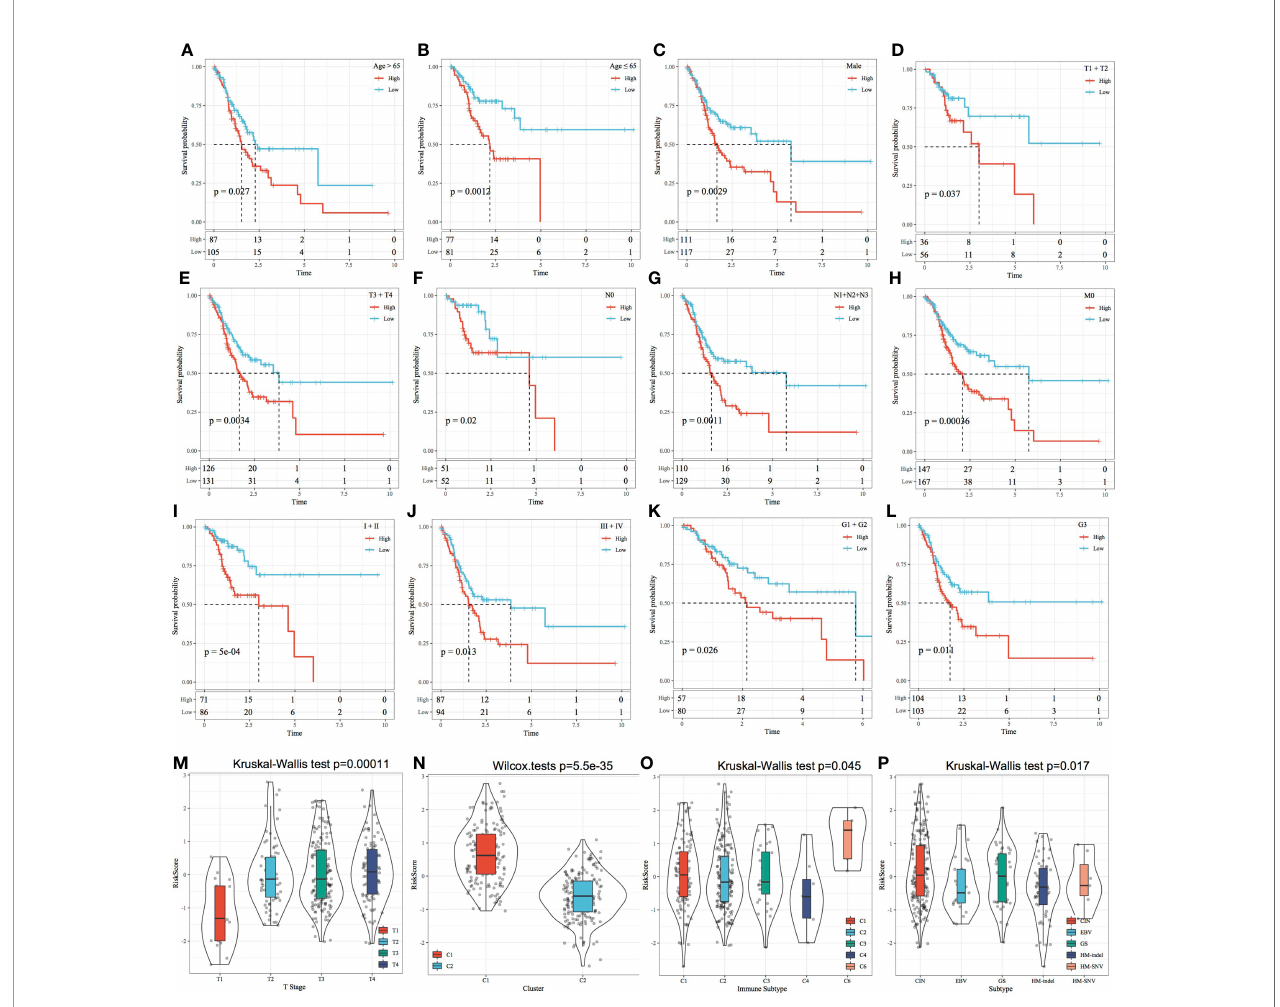
FIGURE 11 | Risk score and prognostic analysis of clinical features. (A – L) Performance of the risk model based on different clinical features. (M) Comparison of the RiskScore among T Stage group samples. (N) Comparison of the RiskScore among the samples of molecular subtypes established in this study. (O) Comparison of RiskScore between samples with existing immune molecular subtype groups; (P) Comparison of RiskScore between samples with existing molecular subtype